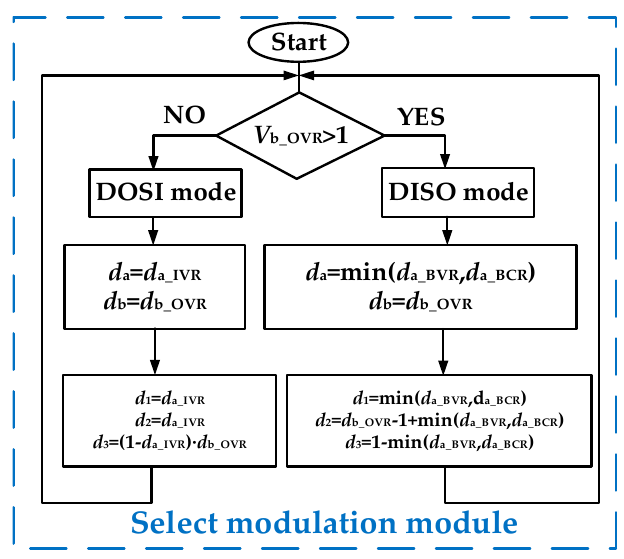
Figure 11. Selection modulation module diagram.